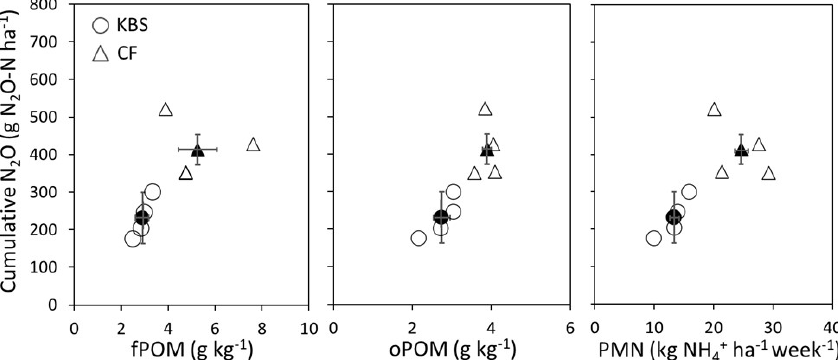
Figure 3. Cumulative N 2 O plotted against fPOM (gkg − 1 ), oPOM (gkg − 1 ), and PMN (kgNH + and CF). Open symbols are values by replicate block, and closed symbols are overall site means. Error bars represent standard error of the means for each site.